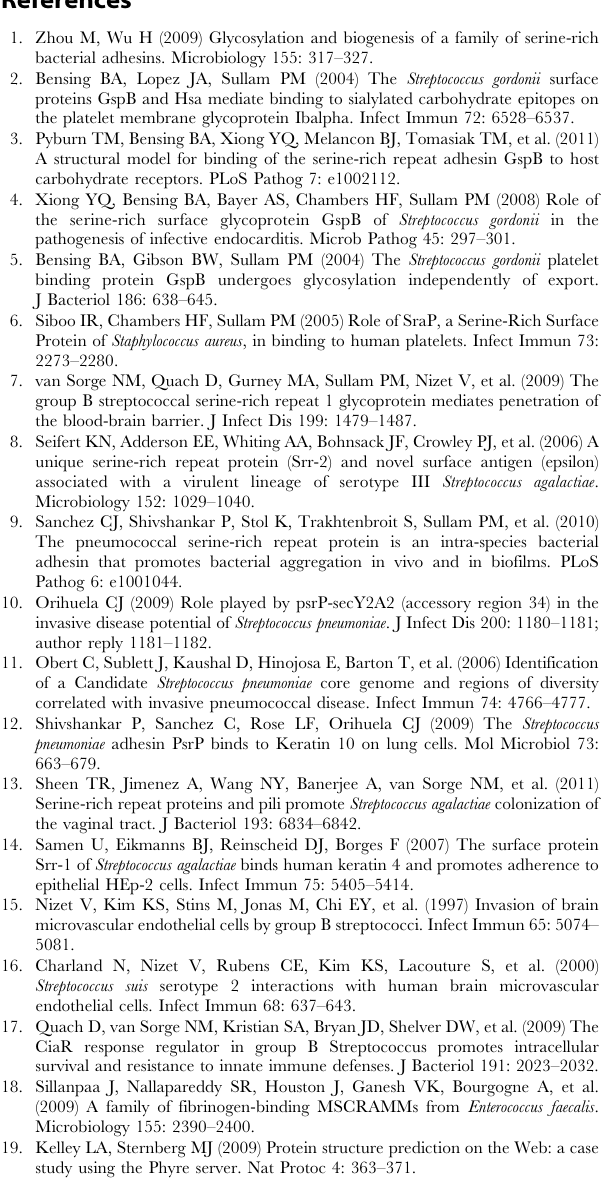
Red, blue and black letters represent charged, polar and hydrophobic residues, respectively. Blue box and red box indicates TYTFTDYVD-like ‘‘latching cleft’’ and ‘‘latch’’ motif respective- ly. (TIF) Figure S6 Analysis of secondary-structure by far-UV CD spectroscopy. (TIF) Figure S7 Inhibition of ClfB-N2N3 and Srr1-BR binding to immobilized fibrinogen with MalE fused fibrinogen